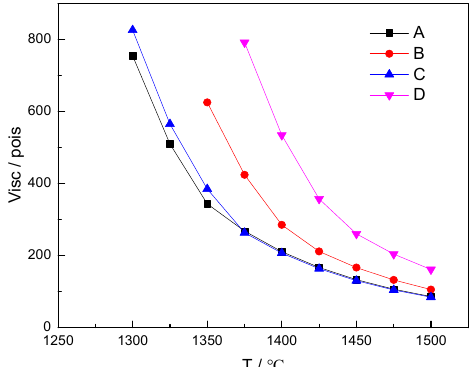
Figure 2. The calculated viscosities of basalt and imitation basalt compounds as a function of temperature: ( A ) basalt; ( B ) imitation basalt compound a; ( C ) imitation basalt compound b; ( D ) imitation basalt compound c.